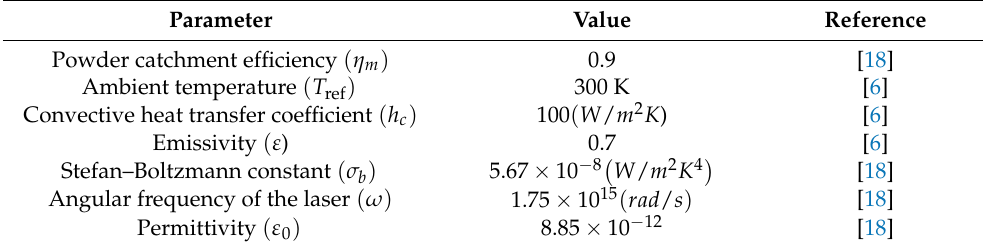
Table 4. Parameters used for simulation